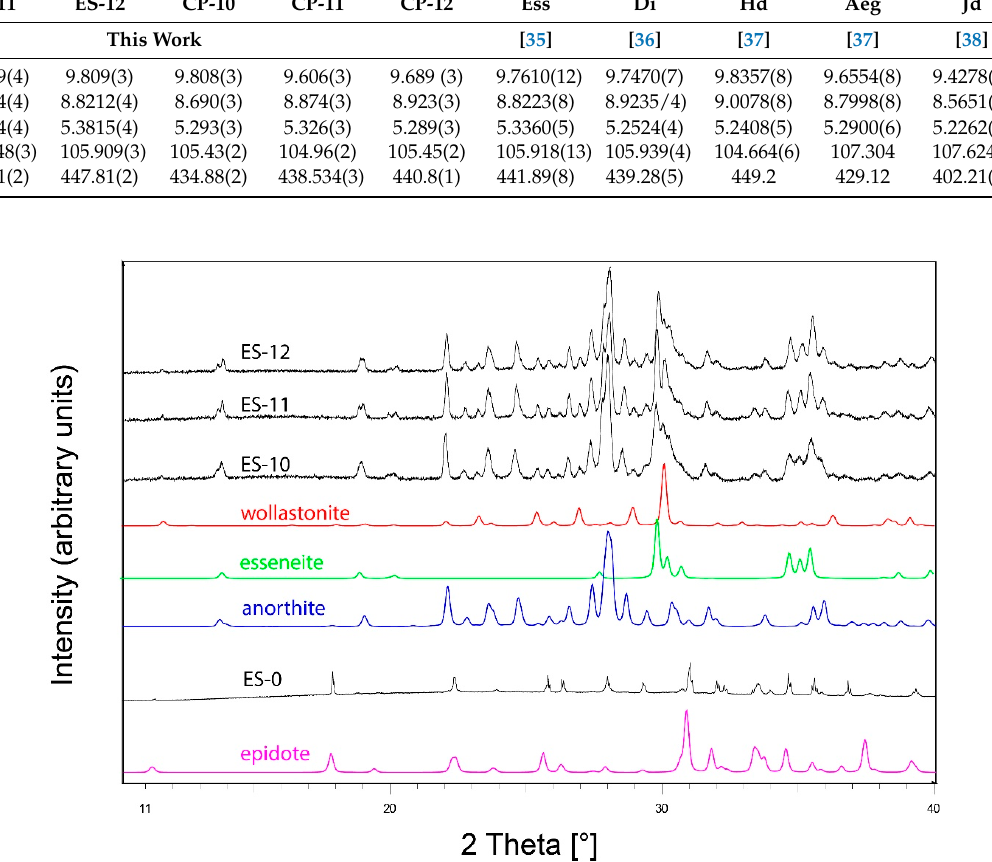
Figure 4. Powder X-ray diffraction patterns of epidote experimental samples (ES) compared to patterns of wollastonite [39], anorthite [40], esseneite [33], and epidote [41] (modeled from structural data using pseudo-Voigt function).